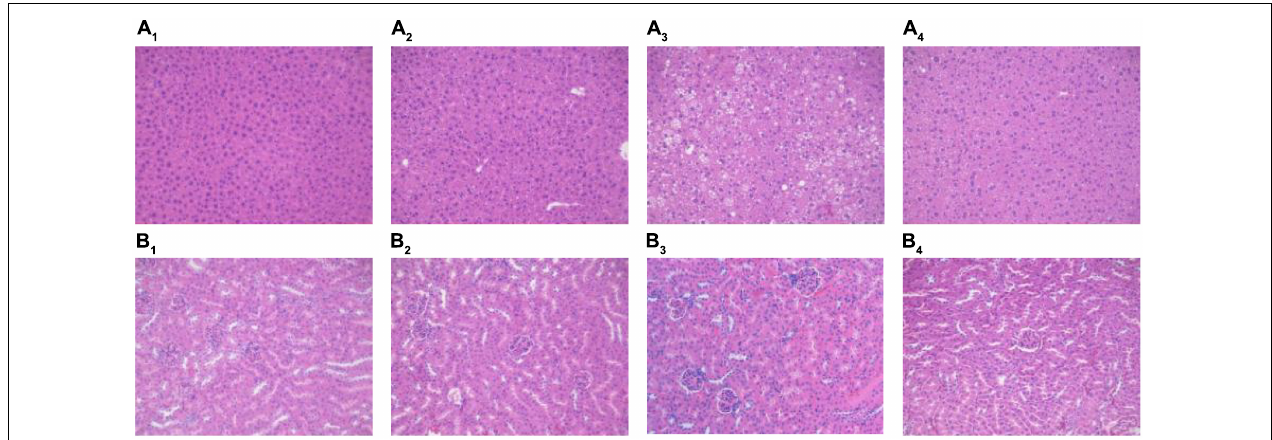
FIGURE 3 | H&E staining results of mouse liver and kidney. Effects of MBPs on (A 1 ) liver of NCD group, (A 2 ) liver of NCD + MBPs group, (A 3 ) liver of HFD group, (A 4 ) liver of HFD + MBPs group, (B 1 ) kidney of NCD group, (B 2 ) kidney of NCD + MBPs group, (B 3 ) kidney of HFD group, and (B 4 ) kidney of HFD + MBPs group. Magnification, 200 ×